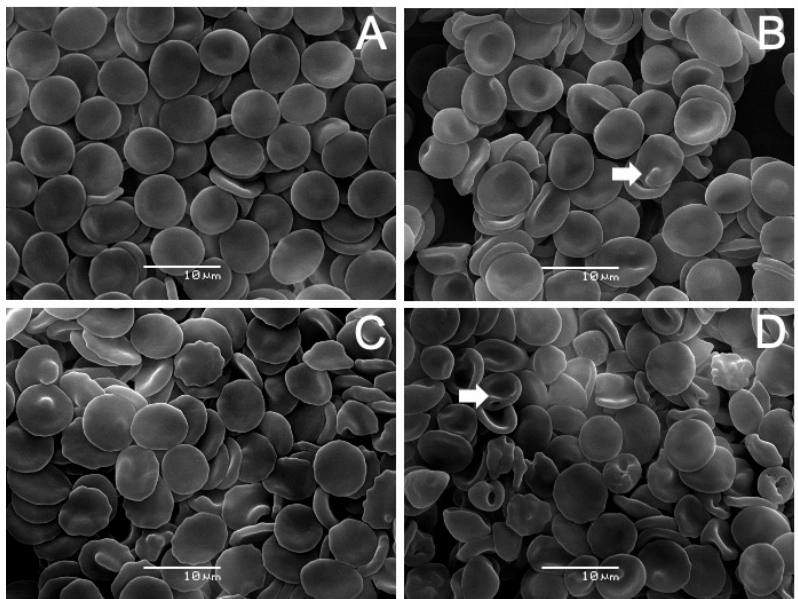
Figure 7. AVCRI104P4 effects on the morphology of human erythrocytes. Images obtained by scanning electron microscopy (SEM) of ( A ) Control, ( B ) 10 μ M, ( C ) 30 μ M, and ( D ) 50 μ M AVCRI104P4. Arrows in Figure 7B,D highlight an echinocyte and a stomatocyte, respectively.